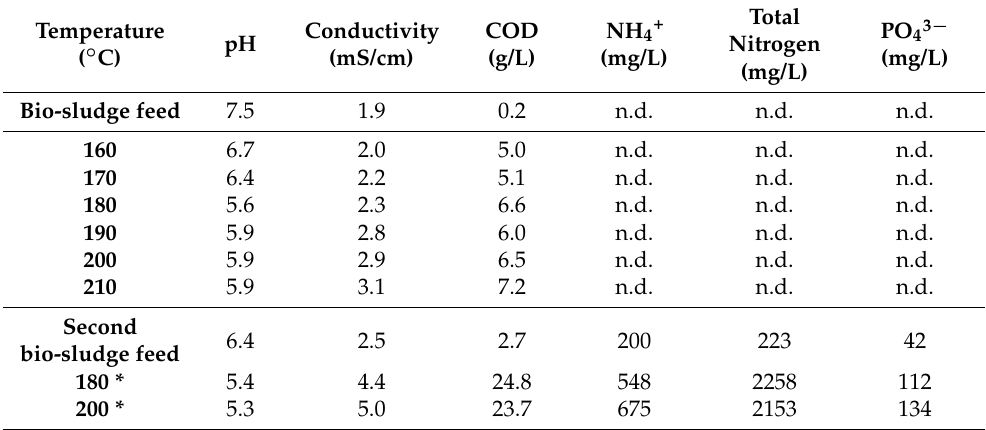
Table 3. Characteristics of two bio-sludge feedstocks before and after processing, and the effect of hydrothermal treatment reaction temperature. * Second bio-sludge batch used, n.d. = not determined. Reported values for COD, NH 4+ , total nitrogen and PO 43 − correspond to the dissolved